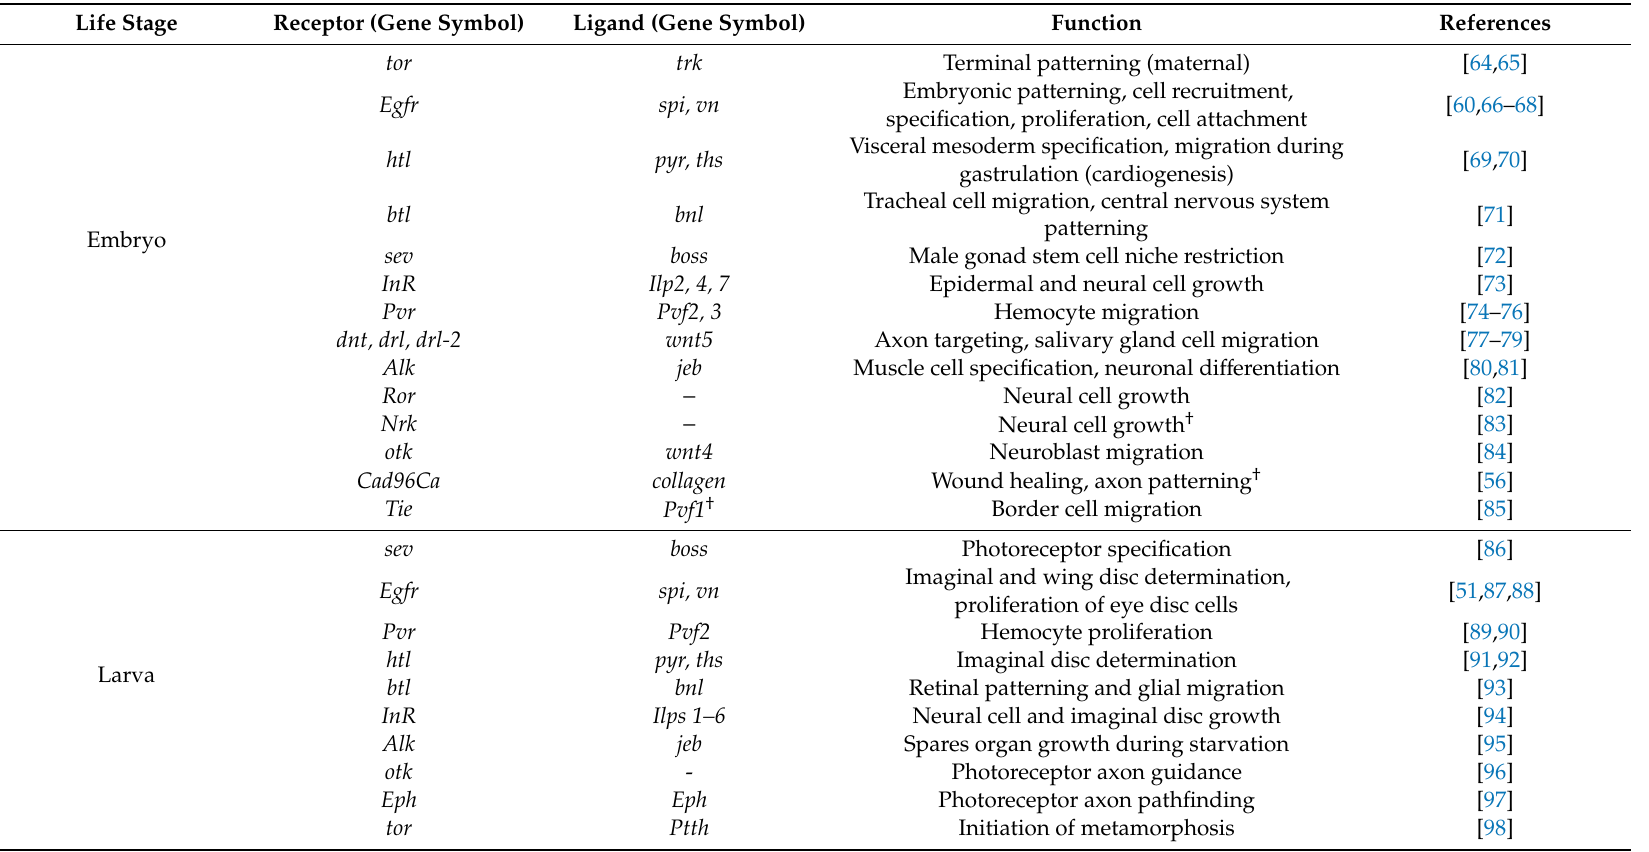
Table 2. Drosophila receptor tyrosine kinases and their functions during